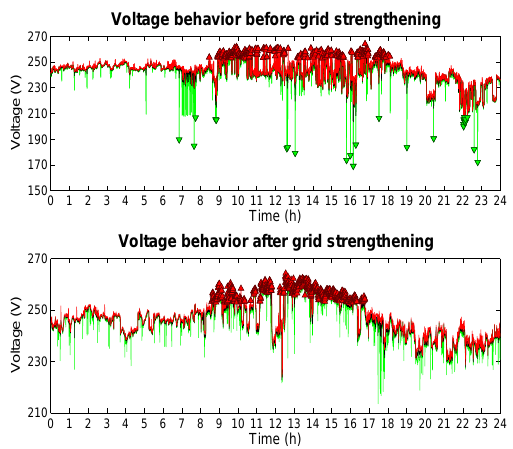
Figure 2. Voltage behavior before ( above ) and after ( below ) the grid strengthening during one day. The red line represents the maximum voltages; the black line represents the medium voltages and the green line represents the minimum voltages. Swells are marked with red upwards ‐ pointing triangles and dips are marked with green downwards ‐ pointing triangles.